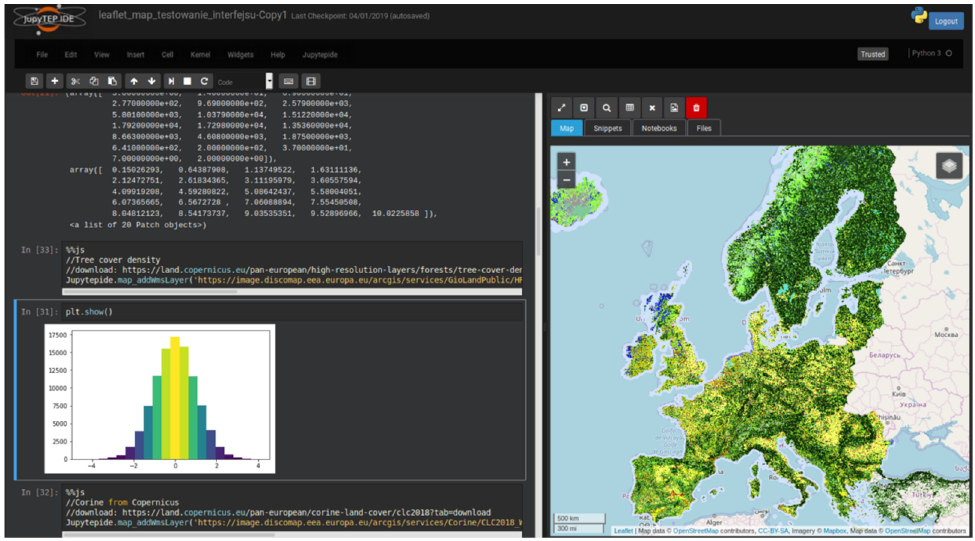
Figure 12. Sample general view of JupyTEP IDE user interface.